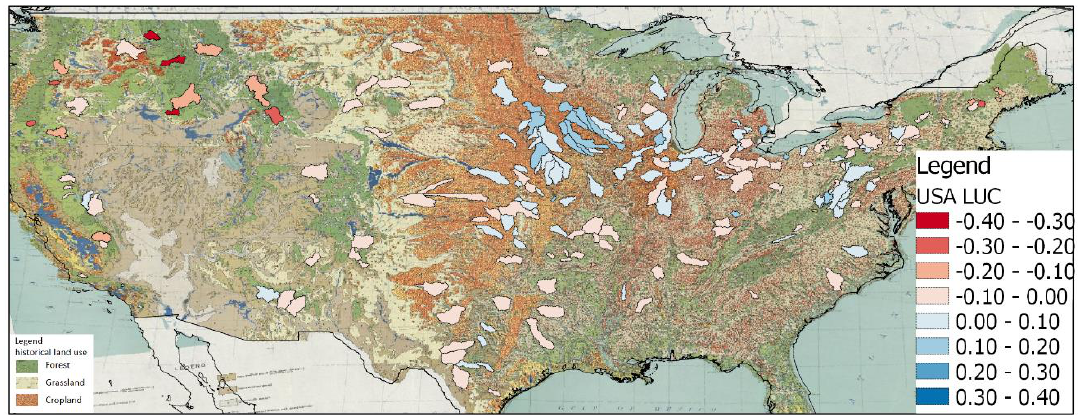
Figure 8. Spatial distribution of LUC values of the American catchments on top of the historical land use distribution of 1950.